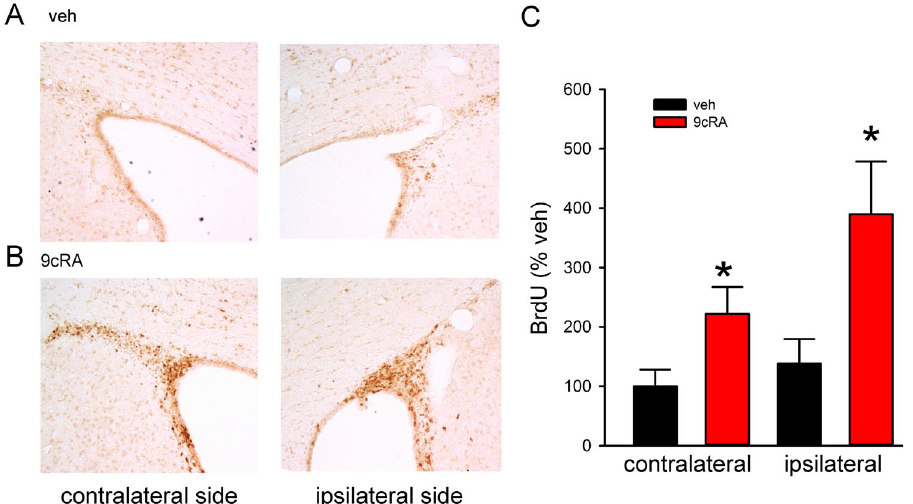
Figure 4. Post-stroke 9cRA treatment enhanced BrdU incorporation in SVZ. Stroke rats received intranasal treatment with 9cRA (n = 7) or vehicle (n = 6). BrdU was given on day 8. Animals were sacrificed for immunocytochemical studies on day 9. ( A ) BrdU immunoreactivity in the SVZ of a stroke animal receiving vehicle treatment. ( B ) Intranasal administration of 9cRA enhanced BrdU incorporation in the SVZ ipsilateral and contralateral to the lesion. ( C ) Post-treatment with 9cRA significantly enhanced BrdU immunoreactivity in SVZ in stroke rats ( * p < 0.05, 9cRA vs veh, two-way ANOVA, n =